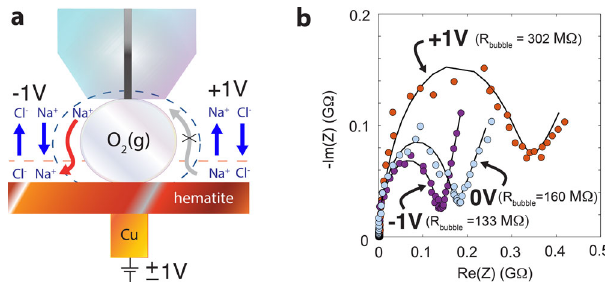
Fig. 4 EIS response of bubbles under an externally applied potential. a Schematic representation of counterion transport under externally applied potentials of − 1 V or + 1 V, here through hematite. The gateway for ion transport is enabled by the overlapping electric double layers of the bubble (capped by dashed blue line) and hematite (capped by dashed red line) at − 1 V (red arrow). This gateway is blocked at + 1 V (gray arrow with ‘ x ’ ). Blue vertical arrows denote direct solution/hematite exchange of counterions affected by the applied potential. While we expect that chloride should bind to hematite, it exerted no response in the EIS data as it has no af fi nity for the bubble surface. b Nyquist (complex-plane impedance) plot showing real (Re) and imaginary (Im) impedance (Z) data (colored circles) and model (lines) of an oxygen bubble pinned on hematite under applied fi elds of − 1 V (purple circles), 0 V (open circuit potential; turquoise circles) and + 1 V (red circles). Measurements were collected over an applied alternating current of ±50 mV in the 1 – 10 5 Hz range through the ultramicroelectrode, and in an aqueous solution of 1.0 mM NaCl at 25 °C. Solid lines are fi ts from the equivalent circuit model of Fig. 2d. More results are in Supplementary Fig.